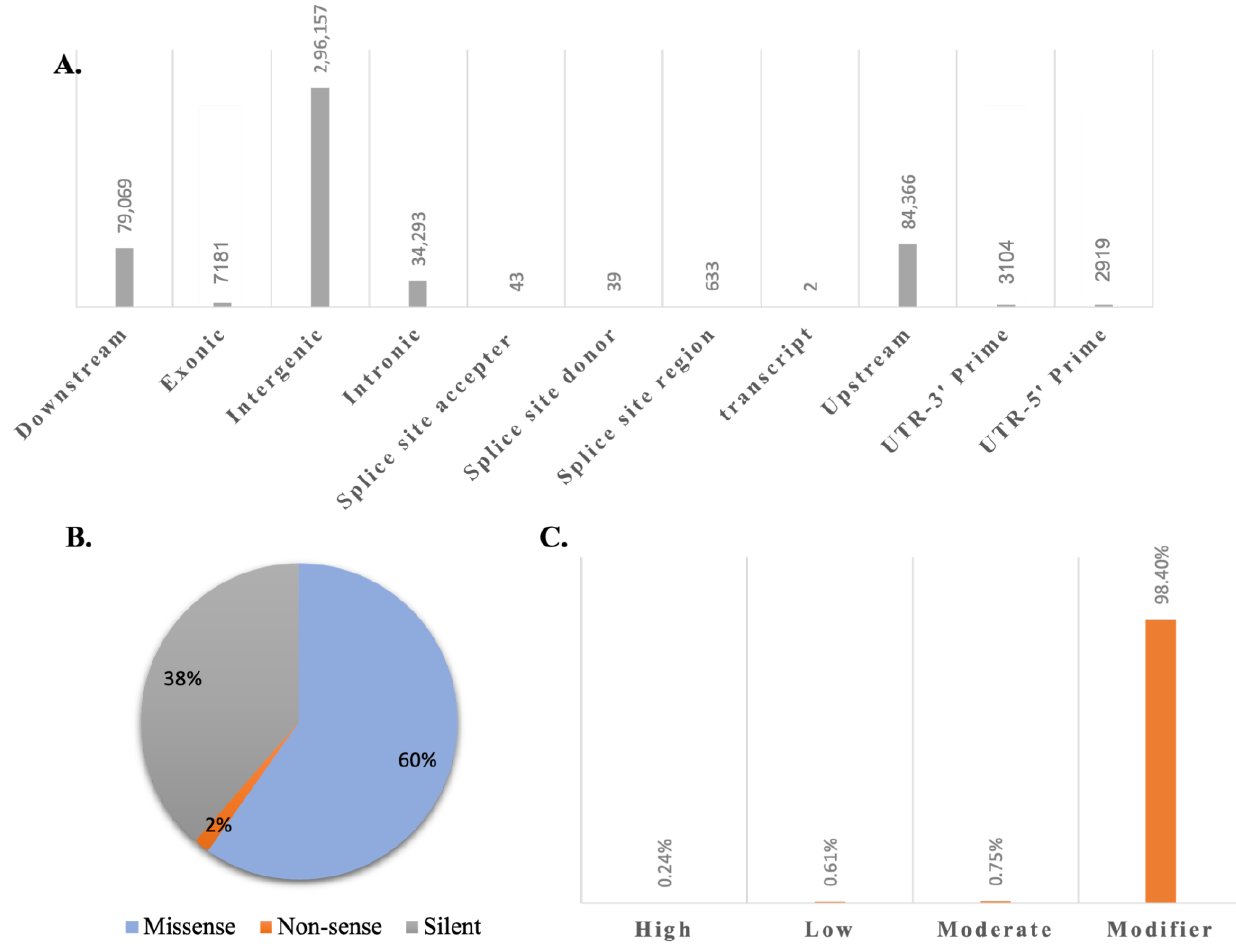
Figure 4. Number of variants in S. lycopersicum cv. Pusa Ruby genome classified ( A ) based on genomic region in which they are present, ( B ) by functional class of effects (in percent), ( C ) by impact (in percent). Variants can be divided into 11 classes based on position in the genome. These